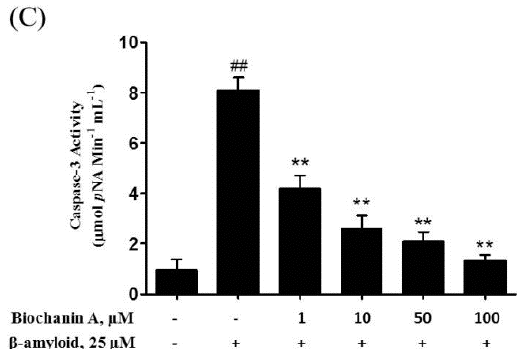
Figure 4. Effect of biochanin A on A β 25–35 -induced caspase activity. PC12 Cells were plated on a collagen type I-coated 6-well plate for 24 h. Subsequently, they were either treated or not (control) with 25 μ M of A β 25–35 with or without biochanin A (1, 10, 50, and 100 μ M). Treated PC12 cells were harvested and subjected to ( A ) caspase-9; ( B ) caspase-8; and ( C ) caspase-3 activity tests. All data represent the mean ± S.E.M. of four independent experiments. ** p < 0.01 compared with the group treated with A β 25–35 alone; ## p < 0.01 compared with the control group. “ − ”and “+”in the figure indicate “in the absent of” and “in the present of” respectively.